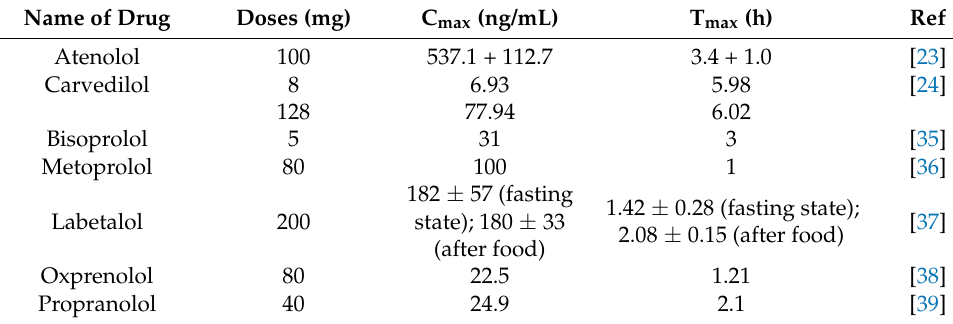
Table 1. List of Cmax of various beta-blockers in plasma. Name of